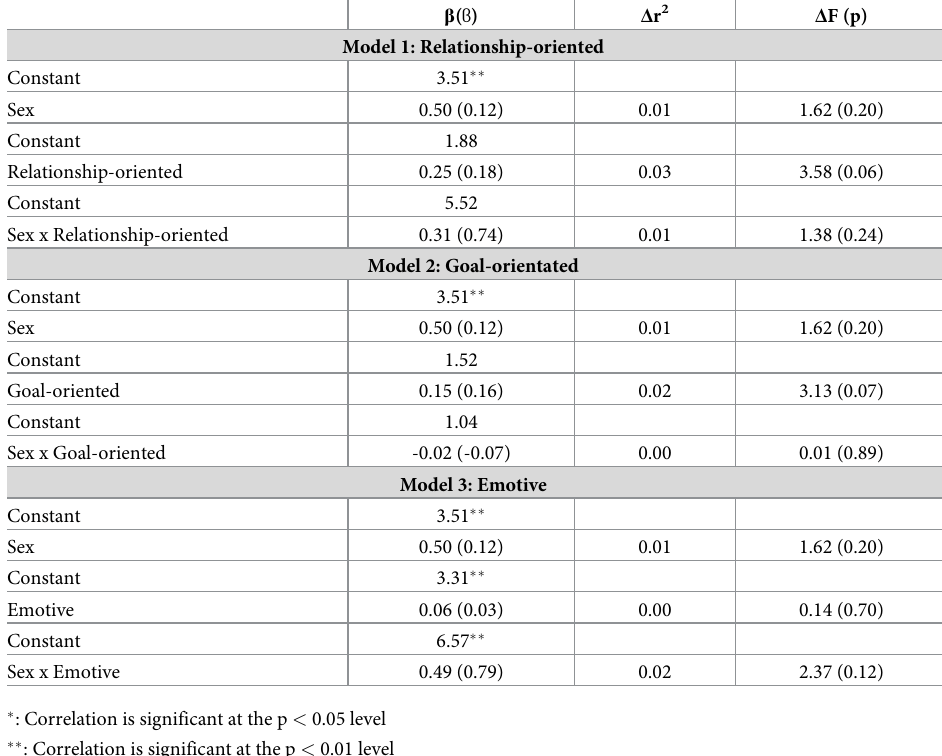
Table 4. Summary of regression analysis for predicting pain severity by sex and GPES subscales